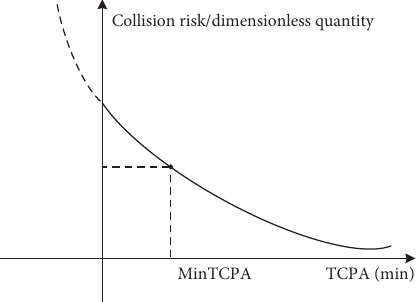
Figure 12: Relationship between TCPA and collision risk.